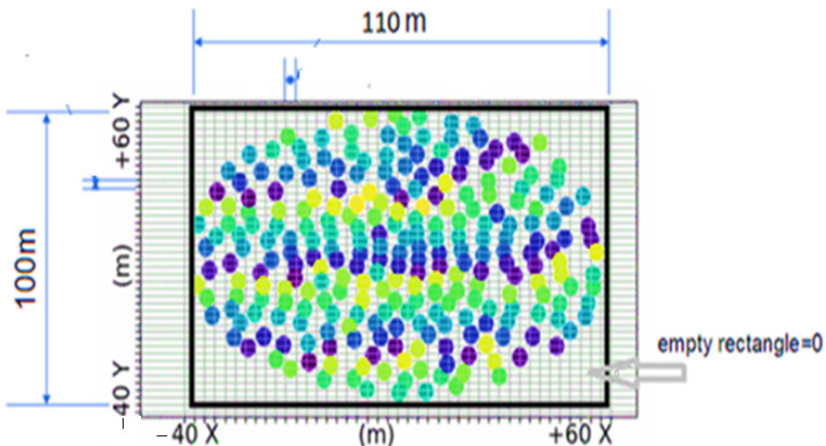
Figure 9. Phase image of antenna locations divided into many cells that contain the relative un- wrapped phase and the applied Fourier space method mesh.